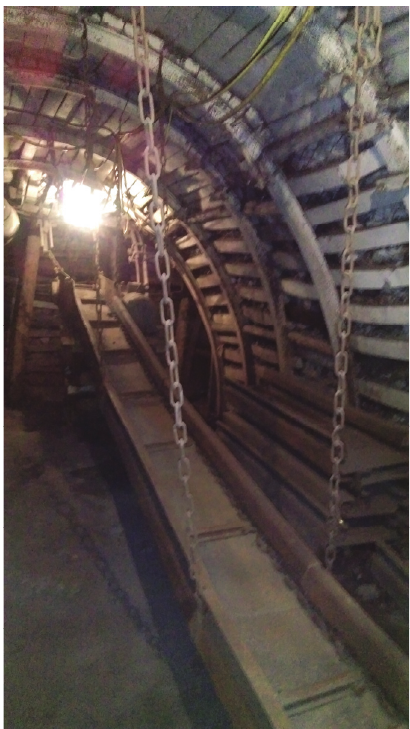
Fig. 1. The scraper conveyor in one of Polish mines (courtesy of A.